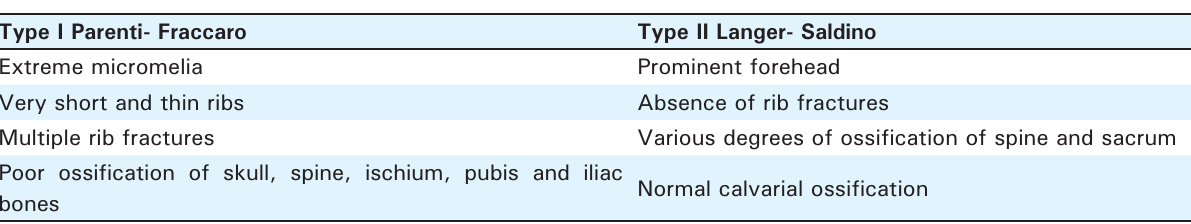
Table 1. Achondrogenesis: type I and II 2 Type I Parenti-